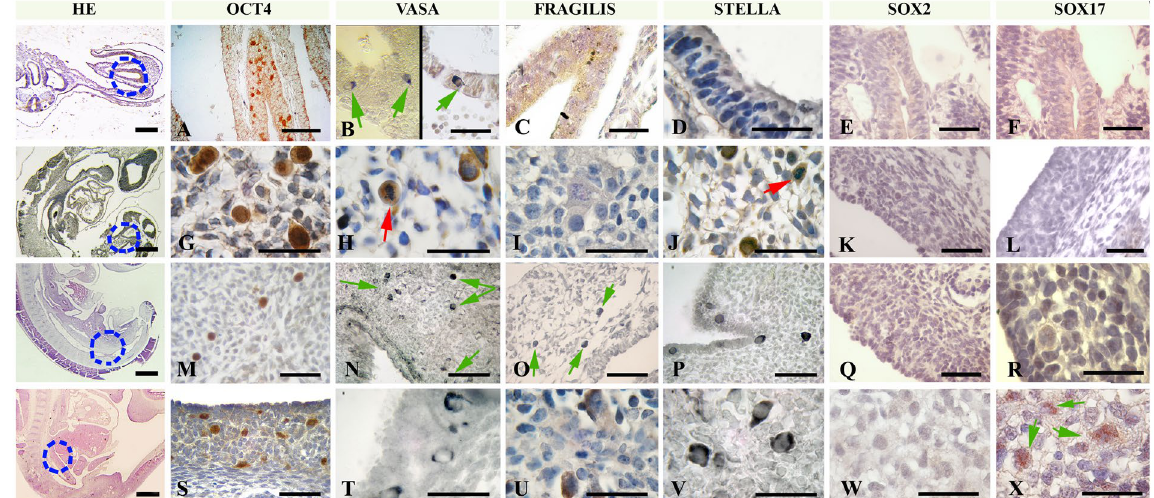
Figure 5. Detection of germ line markers in cells migrating through the dorsal mesentery and colonizing the genital ridge. ( A ) OCT4- and ( B ) VASA-expressing migratory-PGCs in the developing hindgut endoderm in embryos with 8–12 pairs of somites; ( C ) FRAGILIS, ( D ) STELLA, ( E ) SOX2 and ( F ) SOX17 were not detectable at this stage. ( G ) OCT4-, ( H ) VASA- and ( J ) STELLA-expressing migratory-PGCs in the mesentery in embryos with 25–30 pairs of somites; red arrows indicate mitotic dividing migratory-PGCs ( I ) FRAGILIS, ( K ) SOX2 and ( L ) SOX17 were not detected at this stage. ( M ) OCT4, (N) VASA, ( O ) FRAGILIS and ( P ) STELLA positive migratory-PGCs in the mesentery in embryos with 35–40 pairs of somites; ( Q ) SOX2 and ( R ) SOX17 were not detected at this stage. ( S ) OCT4-, ( T ) VASA-, ( U ) FRAGILIS-, ( V ) STELLA- and ( X ) SOX17-positive migratory- PGCs colonizing the genital ridge in embryos with > 50 pairs of somites; ( W ) SOX2 was not detected at this stage. HE column: general view of embryo sagittal sections showing the area detailed in the corresponding lines (blue dotted circles). Green arrows indicate immune-positive cells. Scale bar: 20 µ m (HE column); 40 µ m ( A – C , E , F , K – Q , S ); 1,000 µ m ( D , G – J , R , T – X